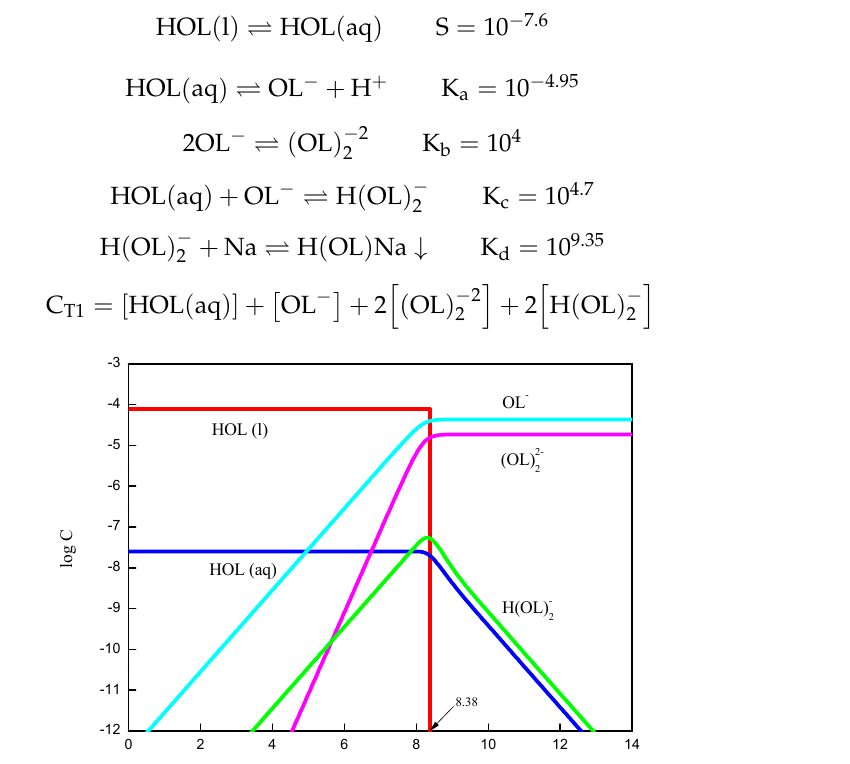
Figure 13. Zeta potential of cassiterite as a function of pH in the presence of Fe 3+ and/or NaOL (Fe 3+ : 8 × 10 − 5 mol/L; NaOL: 4 × 10 − 4 mol/L).